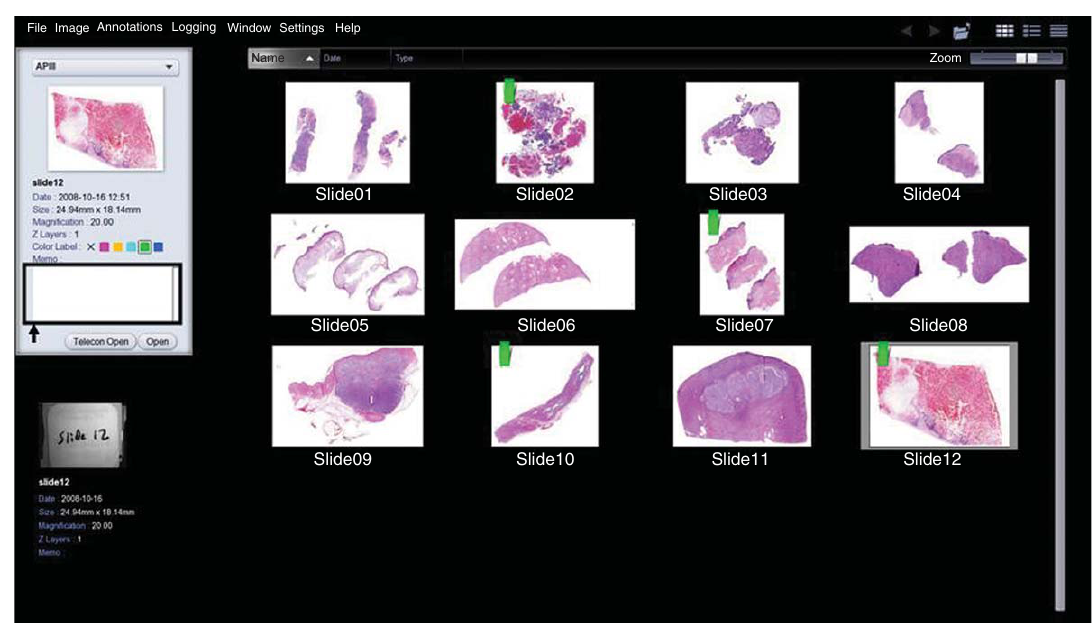
Fig. 8. Slide Selection GUI: This GUI shows more details in the thumbnail images. The GUI also shows posted comments within box, if there are any. And details regarding the slide information can be inserted in the box here shown blank.